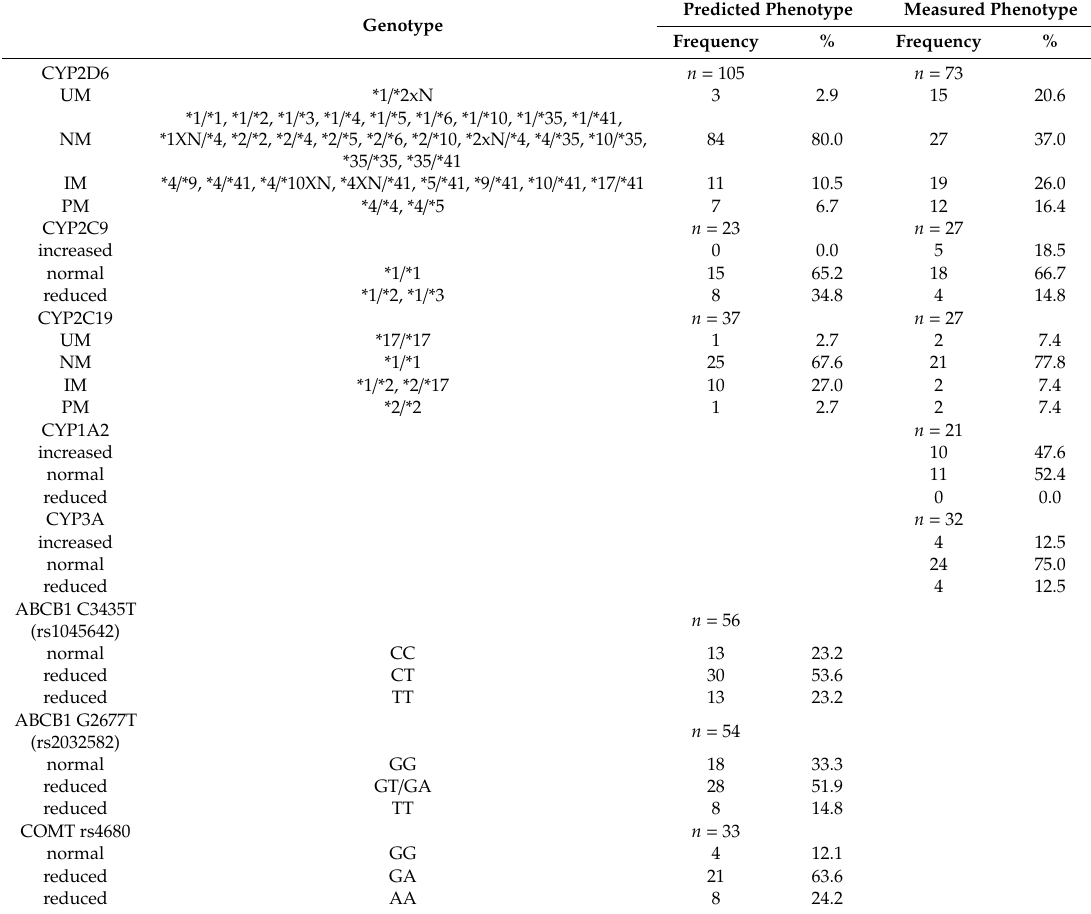
Table 3. Genotype, phenotype predicted from genotype and measured phenotype ( n = 155 patients).